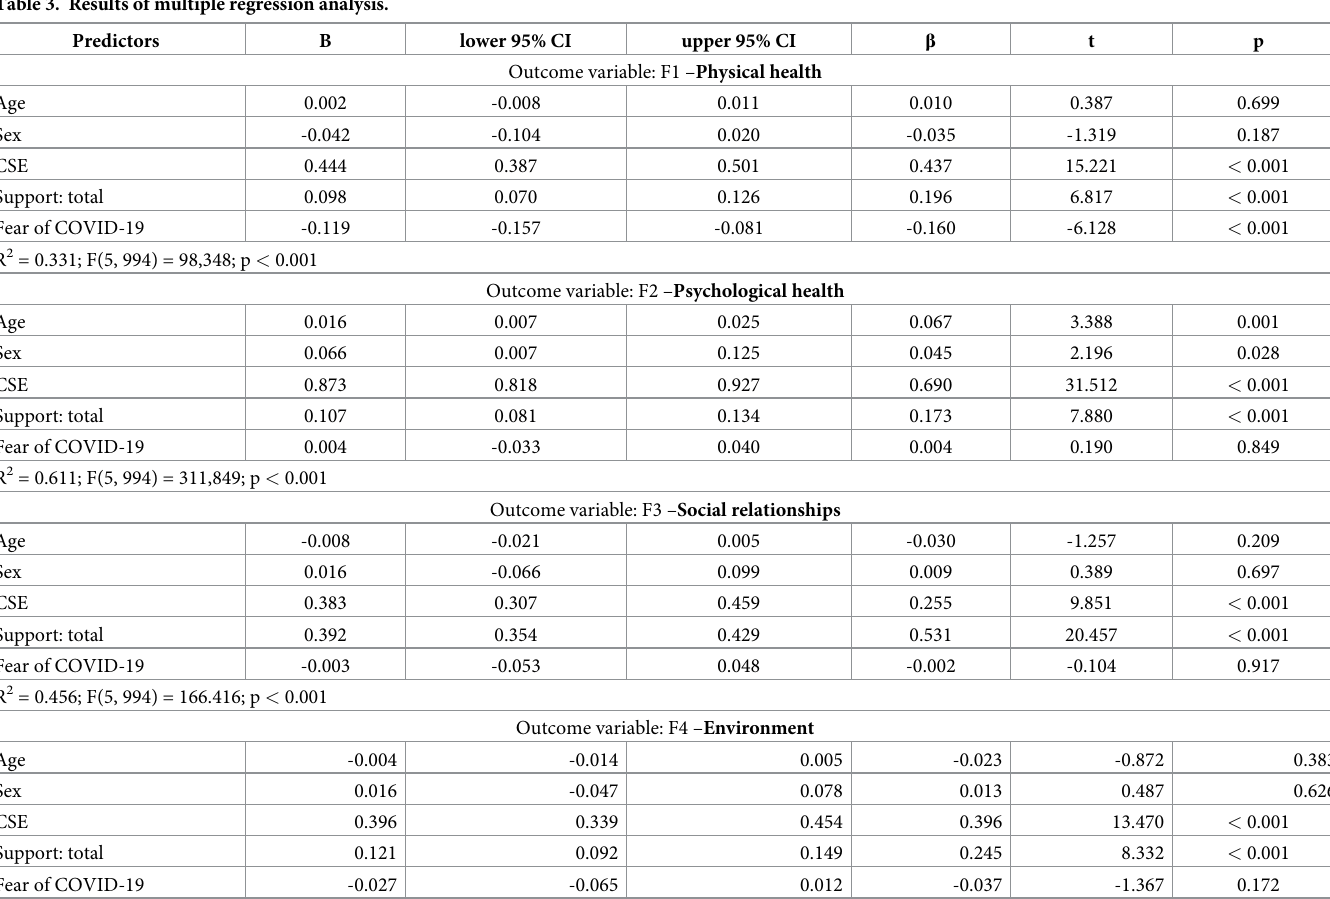
Table 3. Results of multiple regression